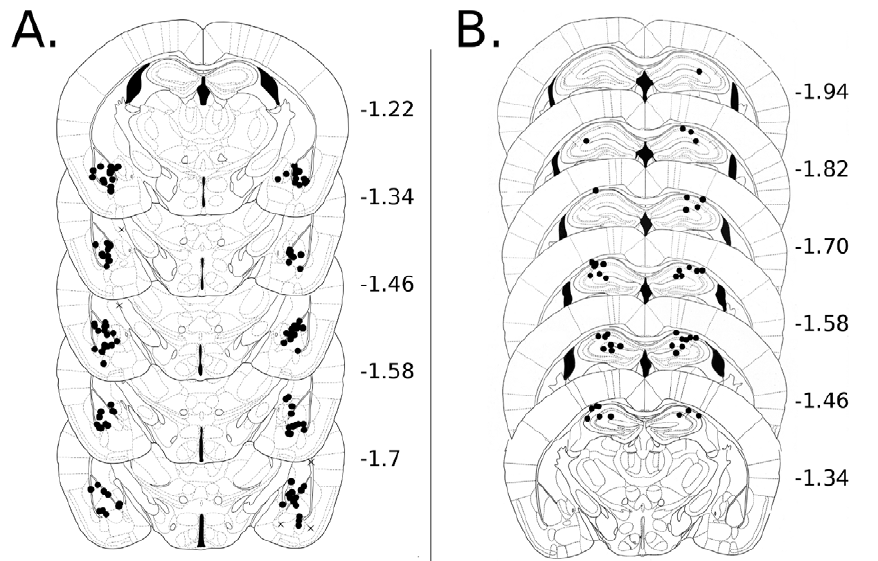
Figure 1. Schematic representation of DH and amygdala cannulae placements. Placements determined to be outside of the target regions are marked with crosses, placements within the target region are marked with solid circles.